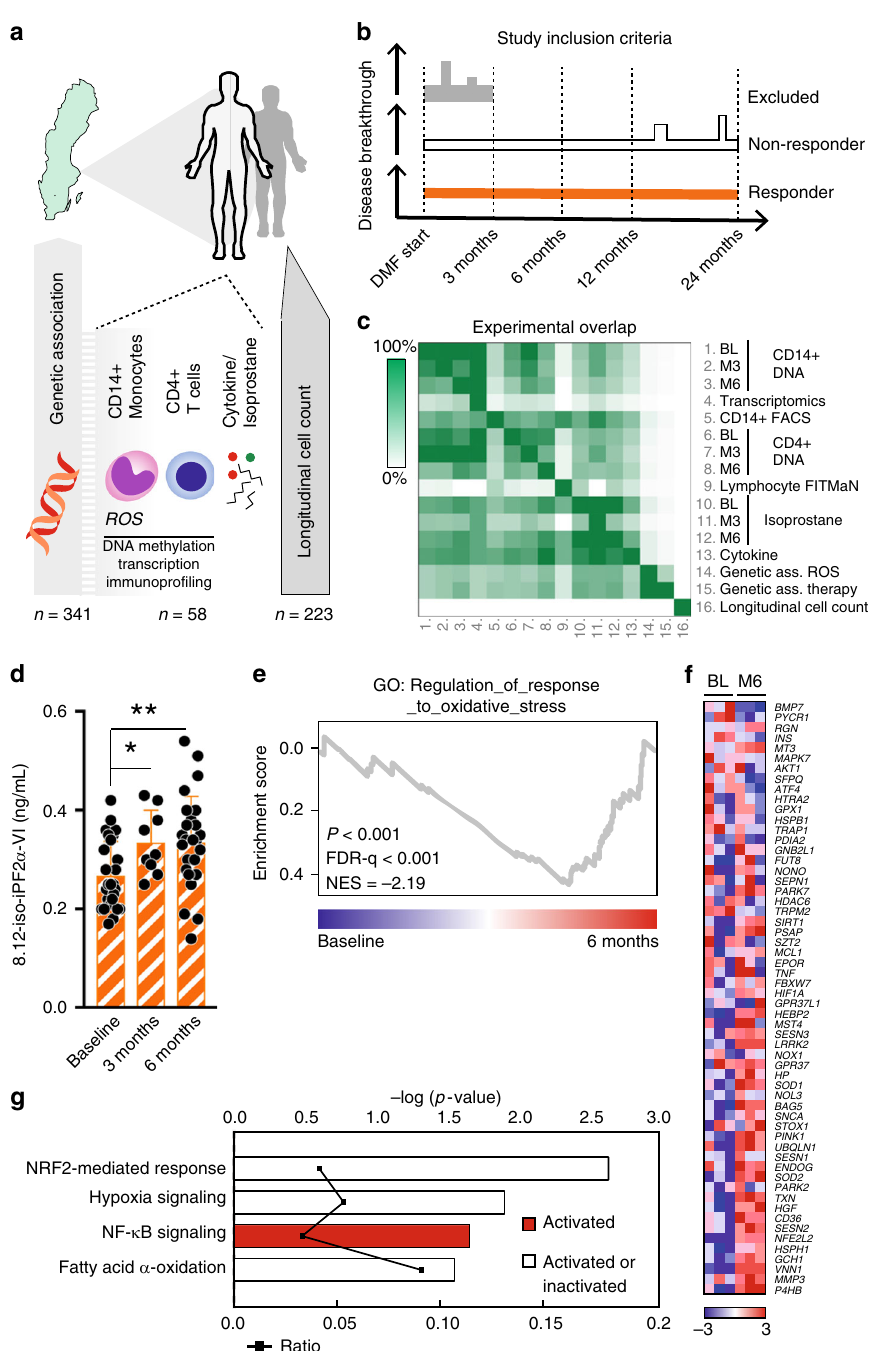
Fig. 1 DMF induce increased isoprostane oxidation and transcription in response to oxidative stress. a Scheme of the study design. Peripheral blood was sampled at the clinic of patients ful fi lling the criteria for RRMS and prescription of DMF. b De fi nition of RRMS patients as responders or non-responders to DMF therapy. c Experimental overlap between different assessments in the study d 8.12-iso-iPF2 α -VI-isoprostane in plasma from paired patients sampled at three months ( n = 9) and six months ( n = 26) after DMF start compared to baseline ( n = 26). e , f GSEA on mRNA from CD14 + sorted monocytes at baseline ( n = 3) and six months ( n = 3) shows an enrichment of upregulated genes involved in GO_REGULATION_OF_RESPONSE_TO_OXIDATIVE_STRESS at six months. ES, P -value and FDR were calculated by GSEA with weighted enrichment statistics and ratio of classes for the metric as input parameters. g Pathway analysis demonstrates oxidative stress-related canonical pathways in response to DMF ( n = 3). Differentially expressed genes ( P <0.01 with average RMA>4, one-way ANOVA) were used in IPA and signi fi cant pathways were determined with the right-tailed Fisher ’ s exact test ( P <0.05). The ratio indicates pathway ’ s activation status upon DMF treatment ( g ). Analysis in ( d ) was done by one-way ANOVA comparing both time points to baseline and graph shows mean and S.D. * P < 0.05, ** P